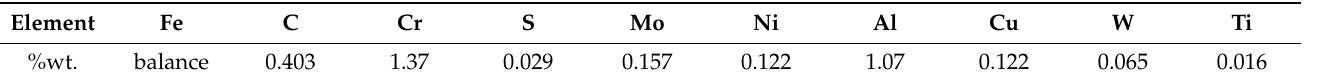
Table 1. Chemical composition of W1.8507 steel.